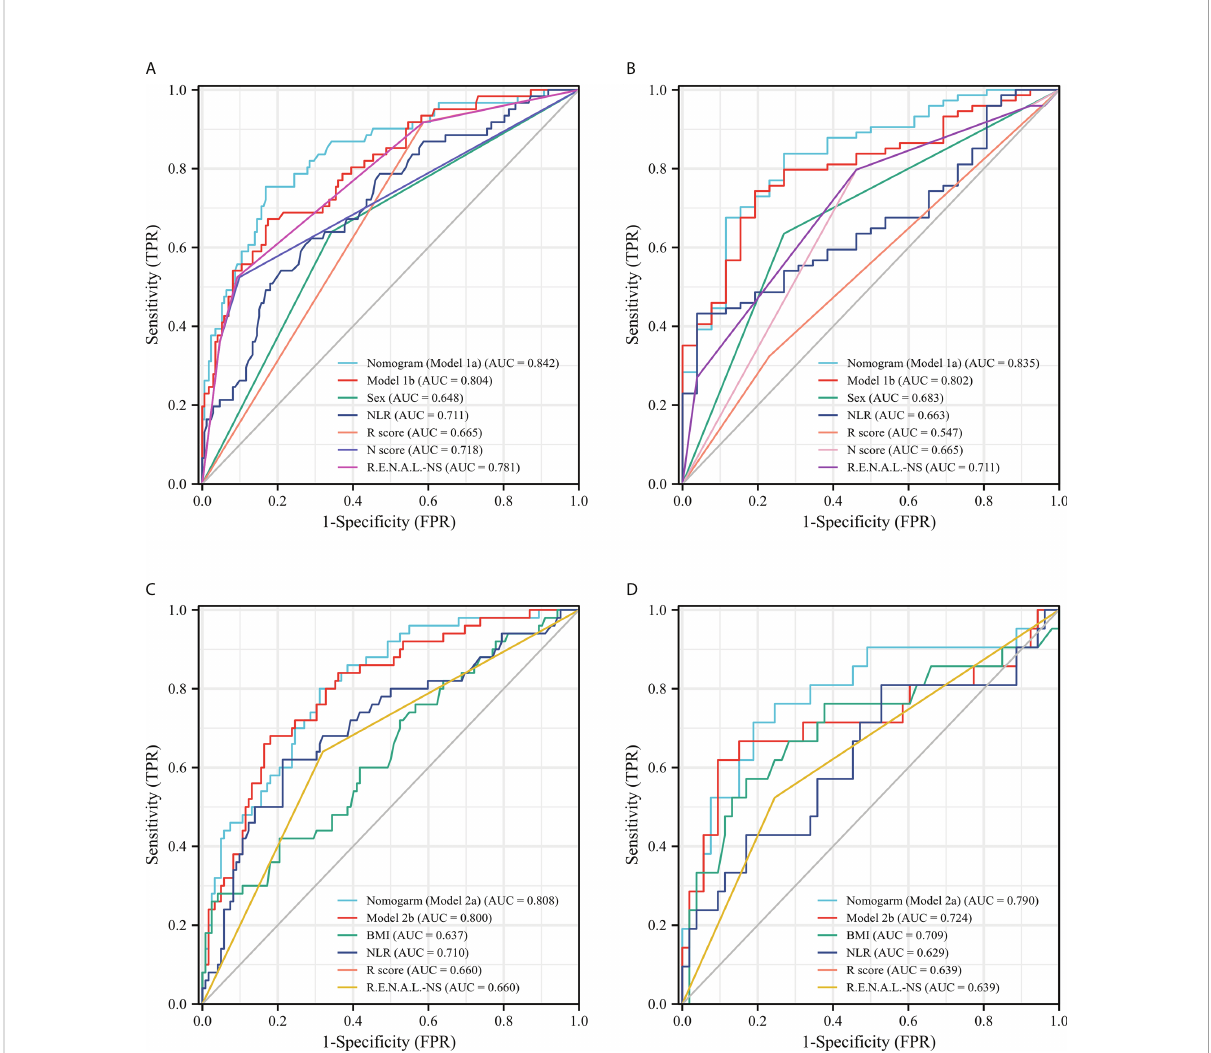
FIGURE 2 ROC curves of single-variable and multiple-variable models for evaluating the predictive performance of MH (A, B) and UP (C, D) in the training set (A, C) and the validation set (B, D) . ROC, receiver operating characteristic; MH, malignant histology; unfavorable pathology; NLR, neutrophil to lymphocyte ratio; R.E.N.A.L.-NS, RENAL- Nephrometry Score; BMI, body mass